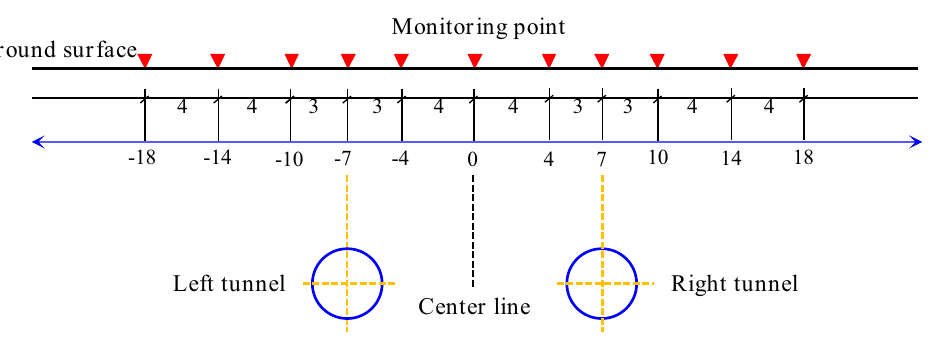
Figure 4. The layout of the settlement monitoring points in the cross-section of the shield